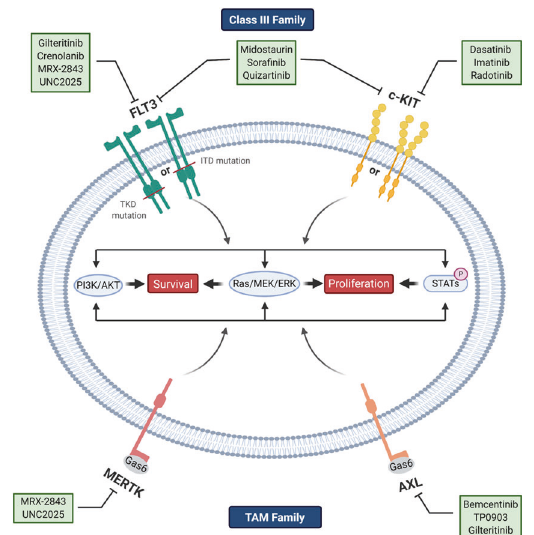
Fig. 3 Inhibition of RTKs in AML. Class III (FLT3 and c-Kit) and TAM (MERTK and AXL) RTKs are implicated in leukemogenesis and progression of AML. RTKs support proliferation and survival through PI3K/AKT, Ras/Ref/MEK/ERK, and JAK/STAT signaling pathways. c-Kit is commonly overexpressed in AML and FLT3 mutations in the tyrosine kinase domain (TKD) or ITD in the juxtadomain result in constitutive activation. MERTK and AXL are overexpressed in AML as is their ligand Gas6. Inhibition of RKTs (via inhibitors listed) inhibits downstream signaling and suppresses proliferation and survival of AML